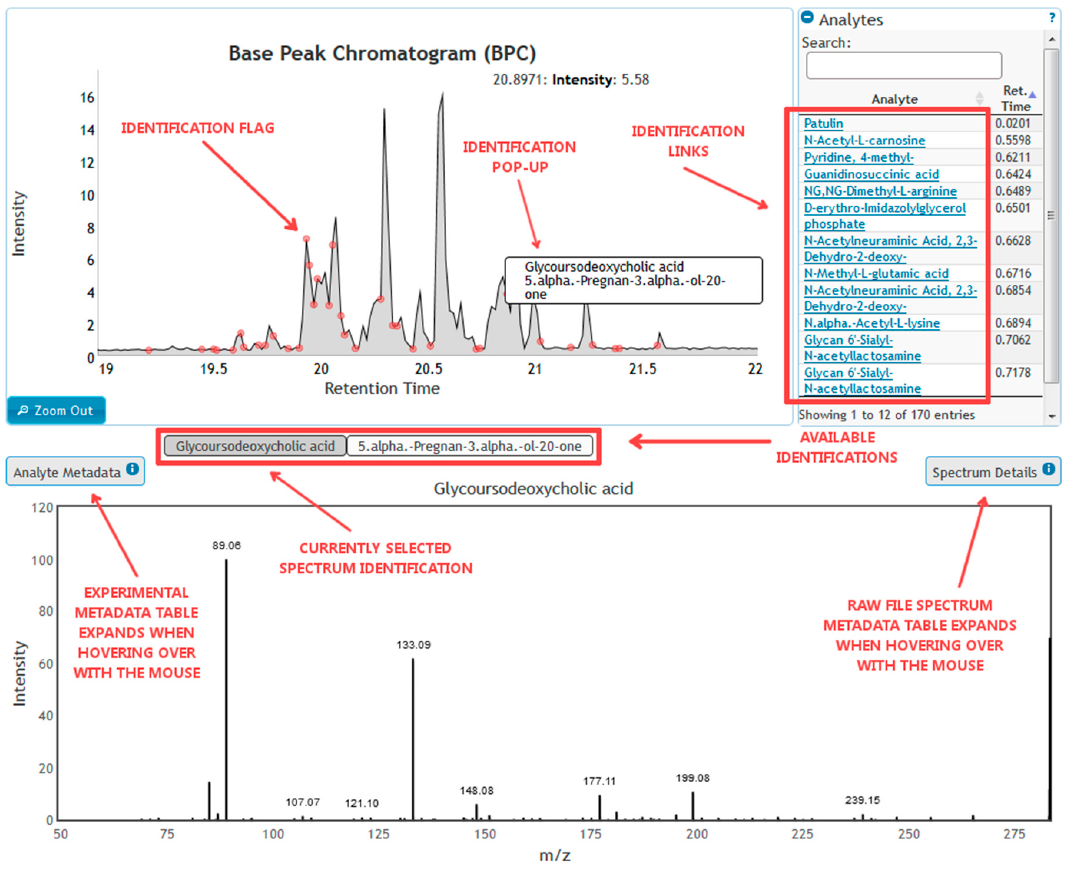
Figure 11. PCA results with uncertainty analysis on the ILS’s GC-MS data using virtual peak